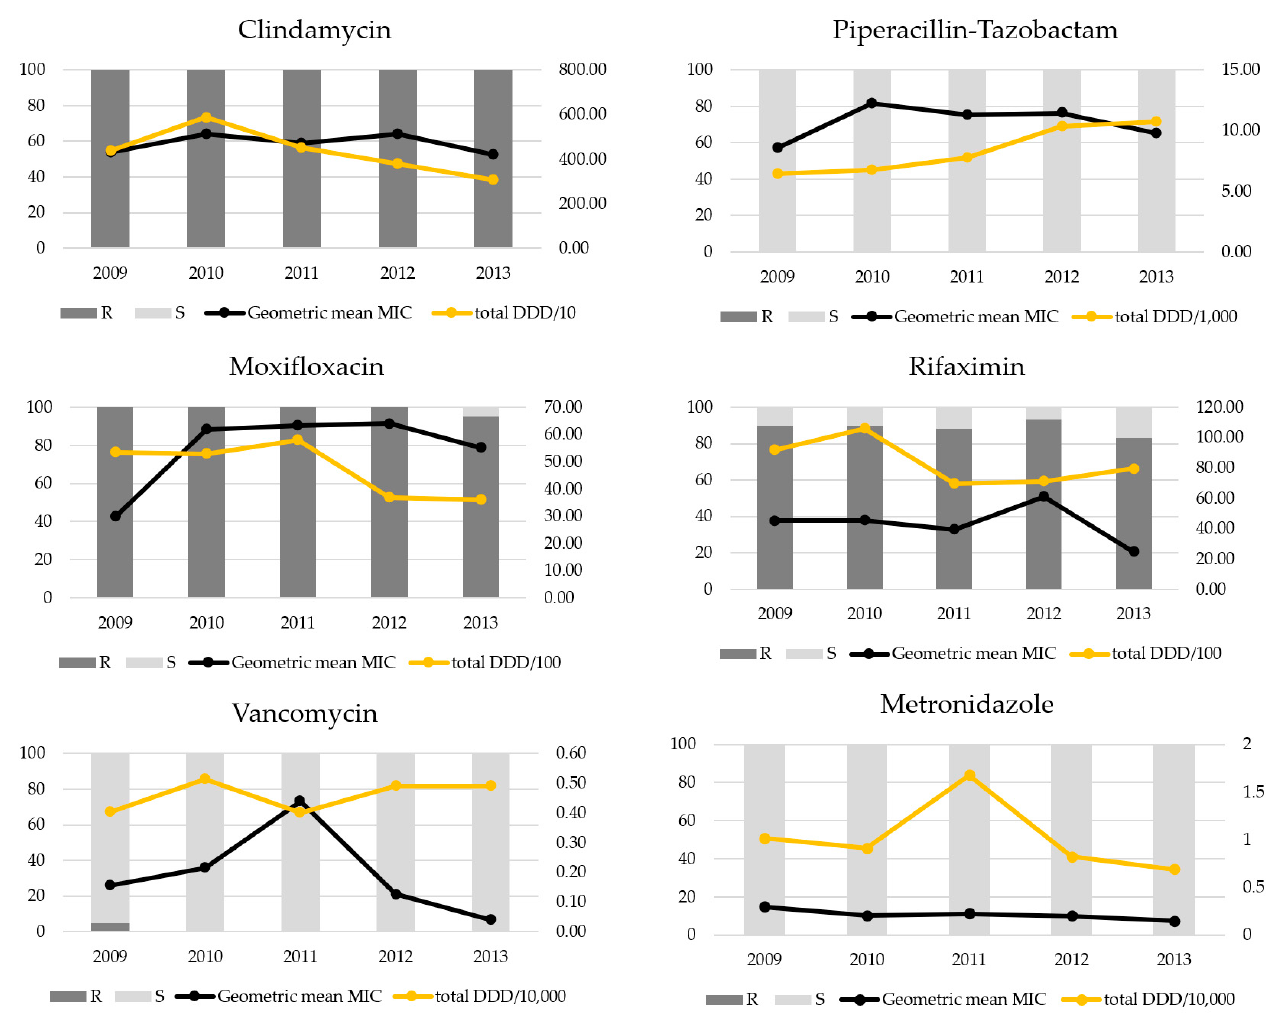
Figure 4. The results of antimicrobial susceptibility tests and geometric mean minimum inhibitory concentrations (MICs) of Clostridioides difficile polymerase chain reaction ribotype 017 against each antibiotic over 5 years. Dark grey areas indicate resistance, and light grey areas indicate susceptibility. The black lines indicate geometric mean MICs, and the yellow lines indicate total defined daily dose (DDD), which is divided by 10 to 10,000. R, resistant; S, sensitive.